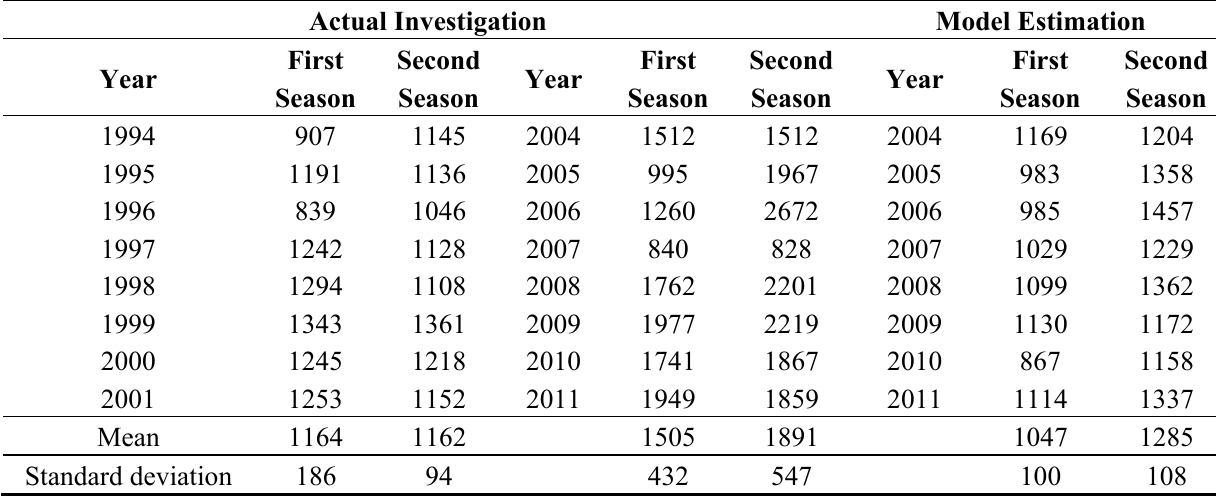
Table 1. Comparison of irrigation water requirement between model estimation and actual investigation. (Unit: